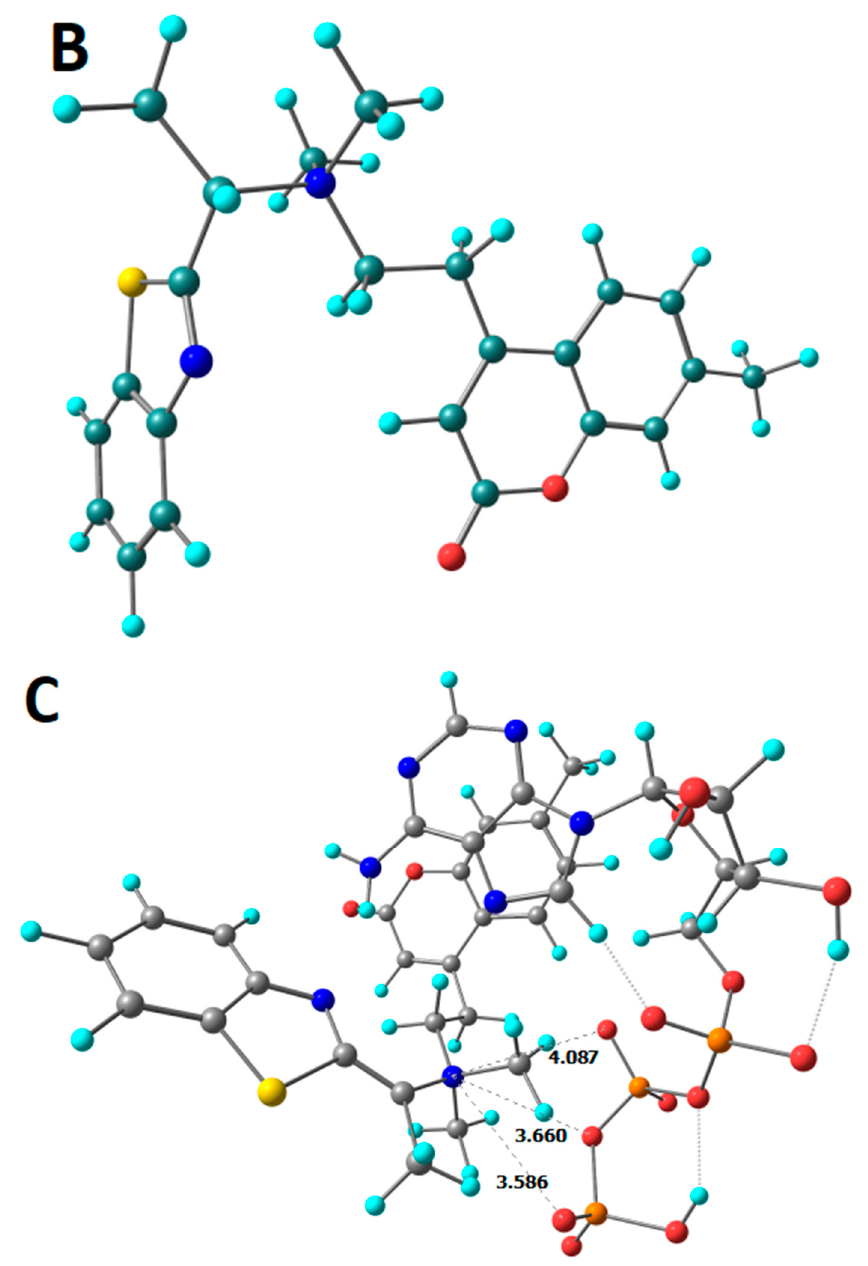
Figure 7. ( A ) Optimized geometry of ATP. ( B ) Optimized geometry of probe 5. ( C ) A model for potential electrostatic interaction between 5 and